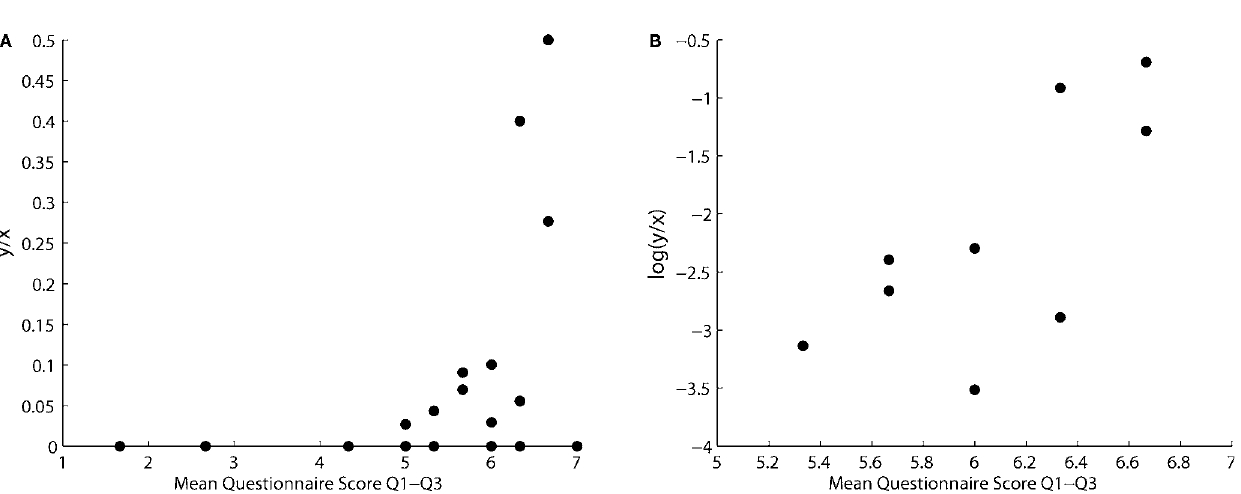
This table shows the medians and interquartile ranges (in brackets) of the questionnaire scores, and the P values indicate the results of the rank sum (Mann–Whitney U) test, which tests the hypothesis that the scores from the synchronous and asynchronous groups come from distributions with equal medians.